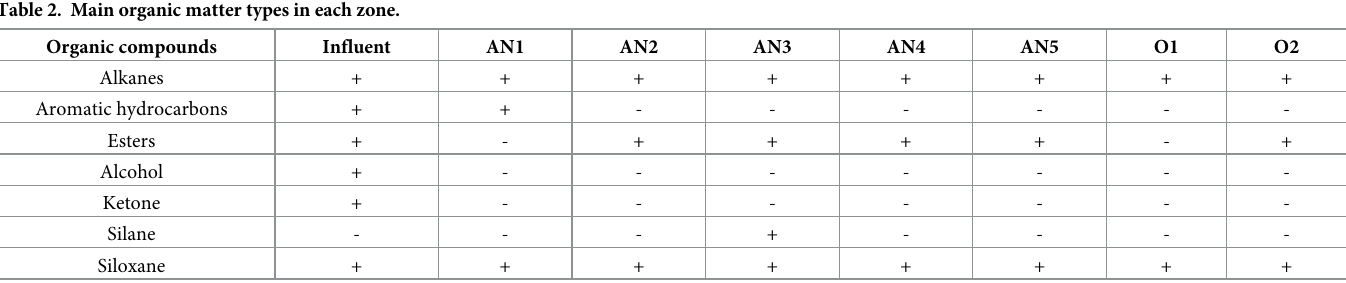
Table 2. Main organic matter types in each